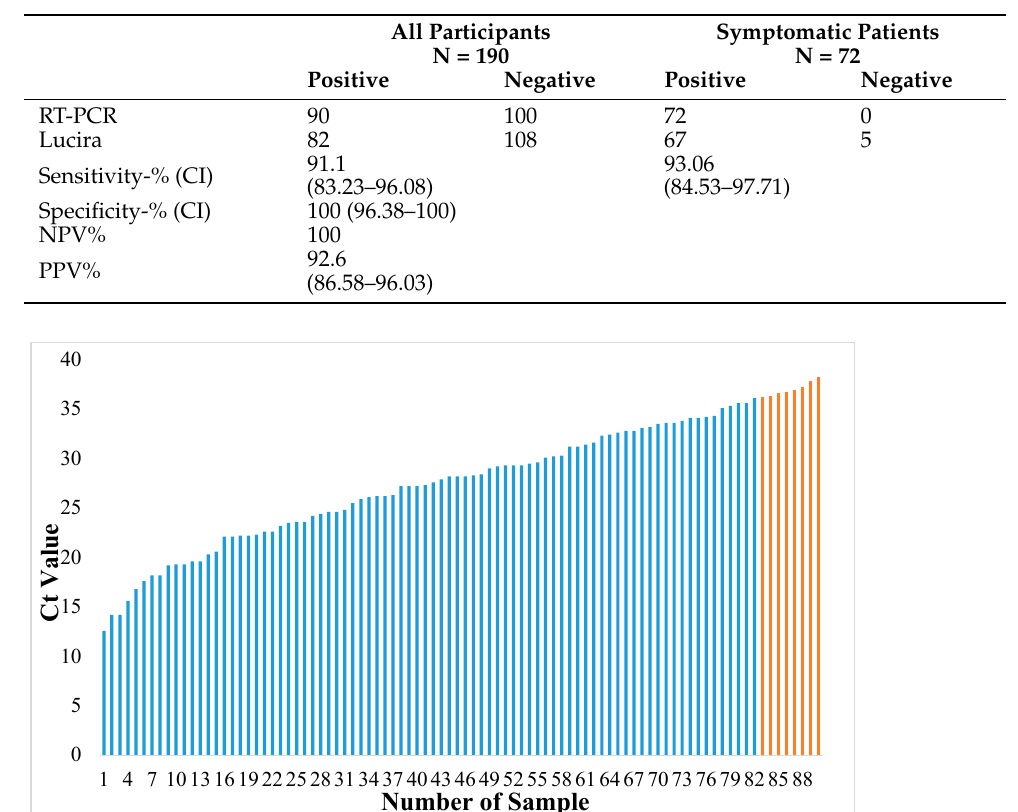
C t va l u e Figure 3. Comparison of Ct values of samples with RT-PCR-positive results between patients with a RT-PCR+/Lucira − results and patients with PCR+/Lucira+ results. The lines represent the mean Ct value. Analysis of time-to-positivity (in the Lucira) of samples from symptomatic and asymptomatic patients found that the average time-to-positivity in samples from symp- tomatic patients was 16.8 min compared to 18.1 min in samples from asymptomatic pa- tients. The lower the Ct value (in RT-PCR), the less time it took for the Lucira to display a positive result ( p < 0.0001, R = 0.8612 (0.7898–0.9096); Figure 4).